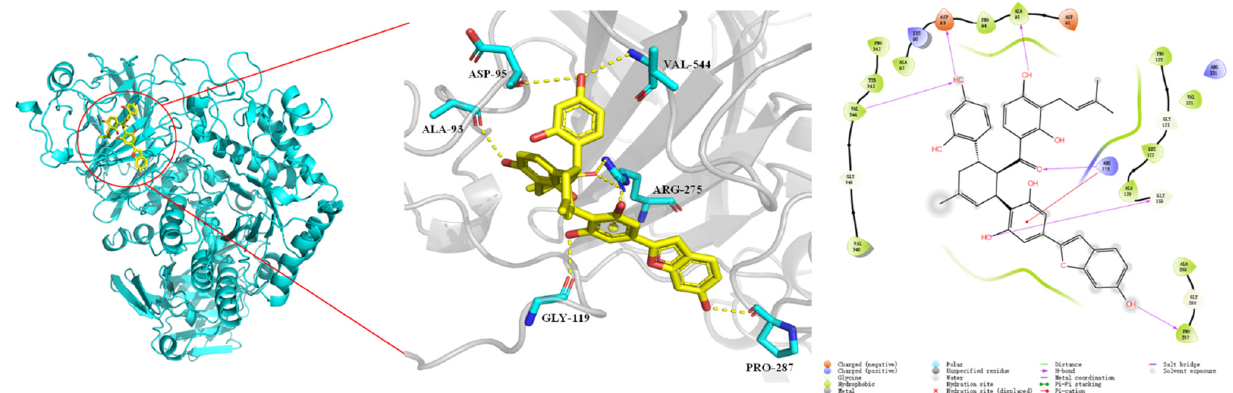
Figure 5. Molecular docking results of chalcomoracin and α